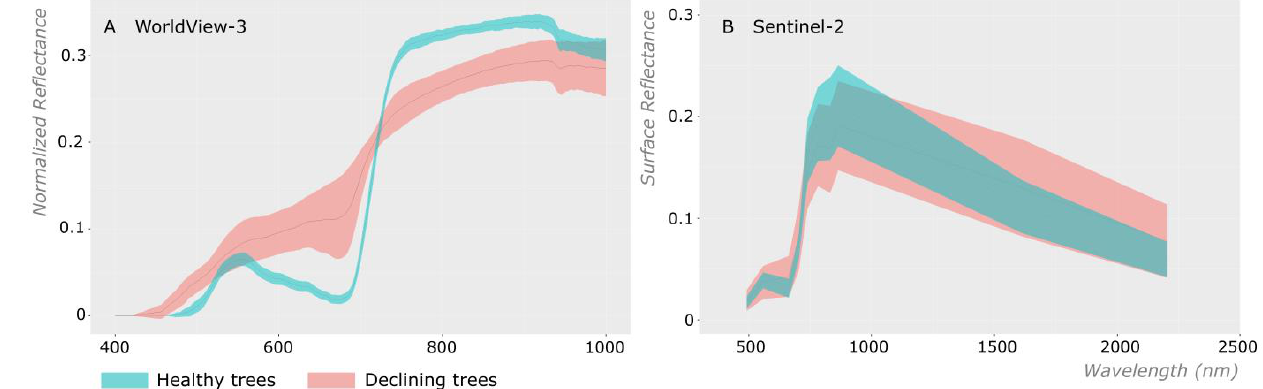
Figure 3. ( A ) Comparison of (unitless) normalized reflectance values (and standard deviation) of needles collected from healthy (green, n = 2140) and declining (red, n = 260) maritime pine trees. Samples were collected throughout the year and analyzed for the spectral range 400 – 1000 nm. ( B ) Sentinel-2 surface reflectance (490 – 2200 nm) of pixels containing healthy (green) and declining (red) maritime pine trees. Table 3. Pigment values and Red Edge parameters for the needles represented in Figure 4 (June 2018 to January 2019).